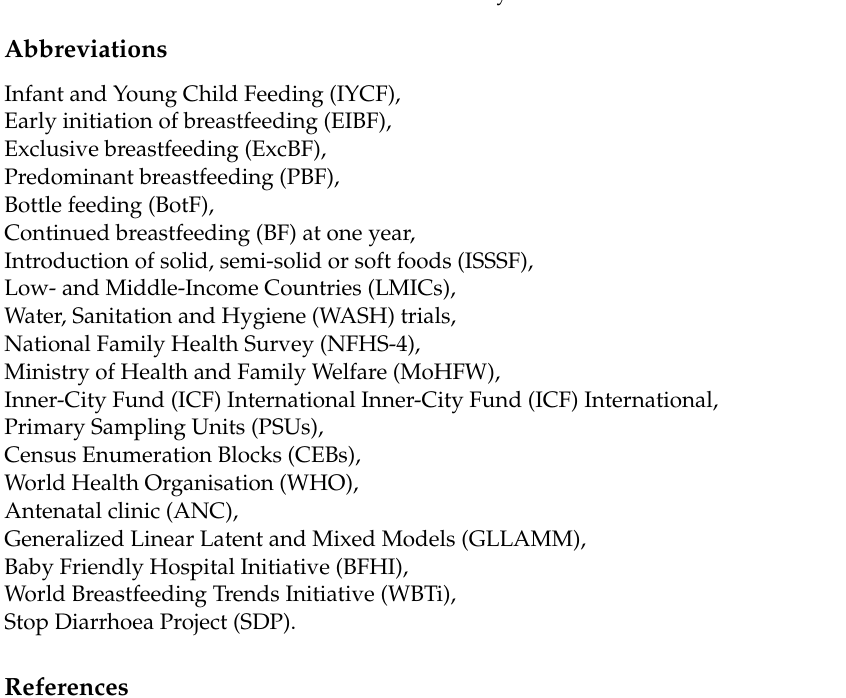
Table S1: Characteristics of the study population (N = 90596), NFHS-4. Table S2: Prevalence of infant and young child feeding (IYCF) indicators among children aged 0-23 months in regional India, NFHS-4. Table S3: Association between and infant and young child feeding (IYCF) indicators and diarrhoea in regional India, NFHS-4. Table S4: Number of missing information after adjusting for potential confounding and exposure